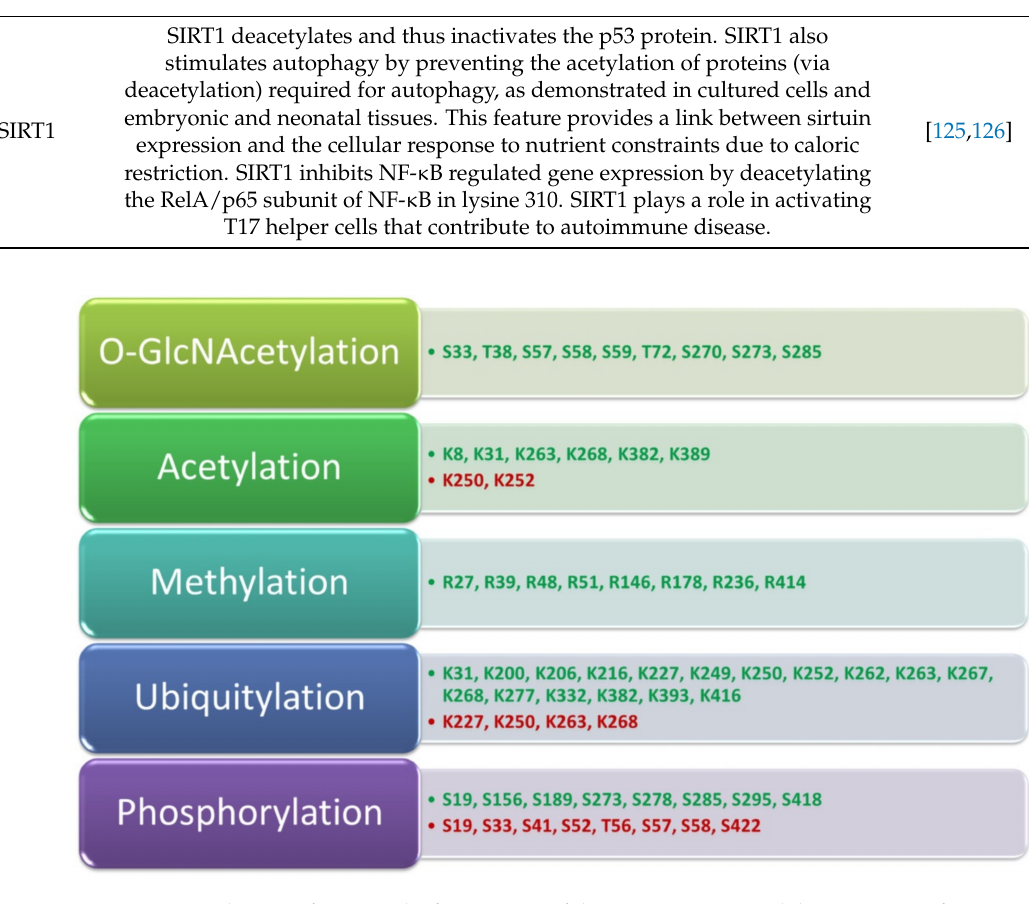
Figure 3. Contribution of PTM to the functioning of the Foxp3 protein and the suppressor functions of Treg lymphocytes. Modifications that positively affect the suppressor functions of Treg lymphocytes are marked in green while those that have a negative effect are in red; based on